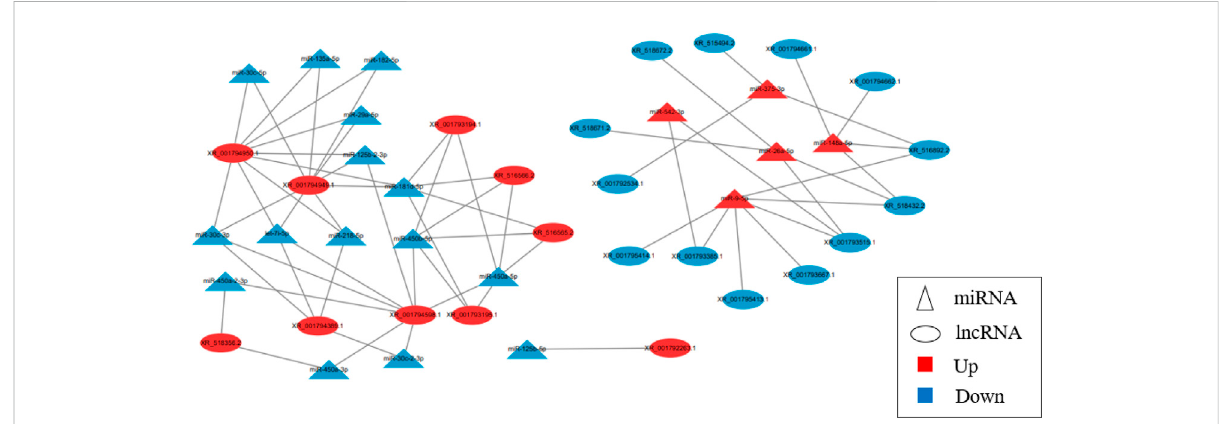
FIGURE 6 LncRNA-miRNA molecular regulatory